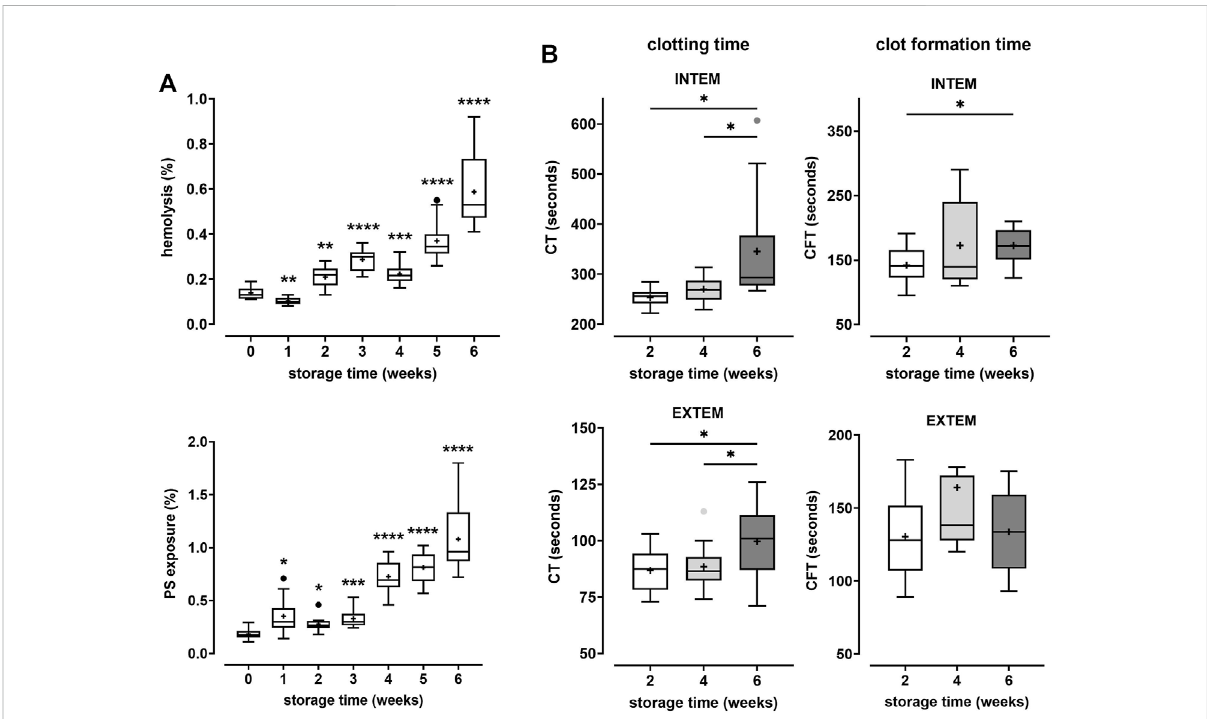
FIGURE 1 Coagulation properties of PRBCs are progressively impaired during storage. PRBCs from blood donated by 12 healthy volunteers were stored for upto 6 weeks. (A) Aliquots wereremovedweekly andtestedfor thepercentage oferythrocytesthat hadundergone hemolysis(top panel)orthat exposed phosphatidylserine (PS) (bottom panel), respectively. Analyses were performed using repeated-measures-ANOVA with Dunnett ’ s multiple comparison. Signi fi cant changes from base values (week 0) are indicated for p < 0.05 *, p < 0.01 **, p < 0.001 *** and p < 0.0001 ****. (B) In weeks2,4and6,aliquotsdrawnfromPRBCunitswererecombinedwithautologousplatelet-richplasma(PRP)preparedfromfreshblooddonations and tested by thromboelastometry applying both INTEM and EXTEM assays. Clotting times (CT) and clot formation times (CFT) are shown in Box Whisker blots with mean values indicated by crosses. Statistically signi fi cant differences were assessed by paired t-tests and indicated by stars (* p ≤ 0.05). Numerical values of the data in Figure 1B are given in Table